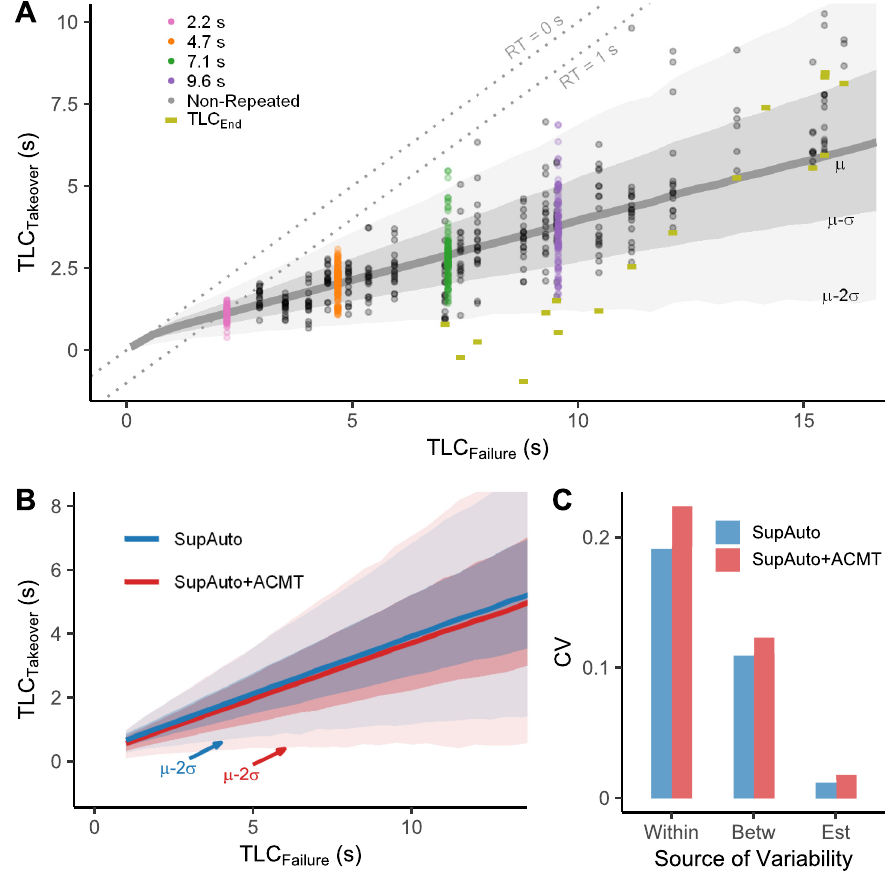
Fig 2. (A) Human failure detection data overlaid on model predictive intervals. The pooled data for SupAuto TLC T is plotted against TLC F . Smaller values of TLC F indicate more critical failure conditions, whereas, smaller values of TLC F indicate that the driver took over closer to the lane edge (TLC T ). The thick grey solid line is the predicted mean TLC T , with the grey bands showing predictive intervals for one and two standard deviations away from the mean. Coloured dots correspond to the Repeated failure conditions and grey dots correspond to Non-Repeated failure conditions. The TLC End values for each tested combination of TLC F and onset time, which limits the observed range of TLC T for the less severe conditions, are shown using gold horizontal bars. To aid interpretation that the reaction times increase as TLC F increases, two dashed lines with constant reaction times are shown by dashed grey lines (RT = 0s, which is the 1:1 line, and RT = 1 s). (B) Model Predictive Intervals. Regression lines and predictive bounds for 68.3% and 95.5% quantiles for SupAuto and SupAuto+ACMT. (C) The variability within the predictions decomposed into within- participant variability, between-participant variability, and estimation uncertainty, shown as the average contribution to the coefficient of variation ( σ pred / μ pred ) of the predictive distribution. The total (average) coefficient of variation is the sum of the three components. Posterior median parameter values were used to make predictions without estimation